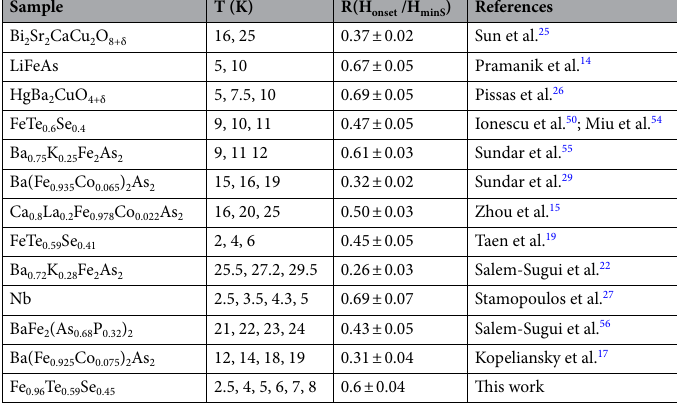
Table 2. Ratio H onset /H minS (R) for several type II superconductors at various